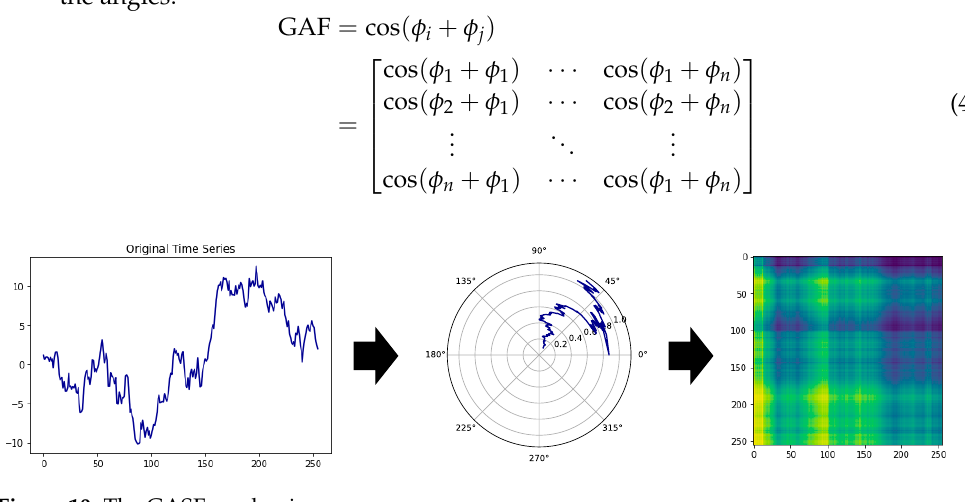
Figure 10. The GASF